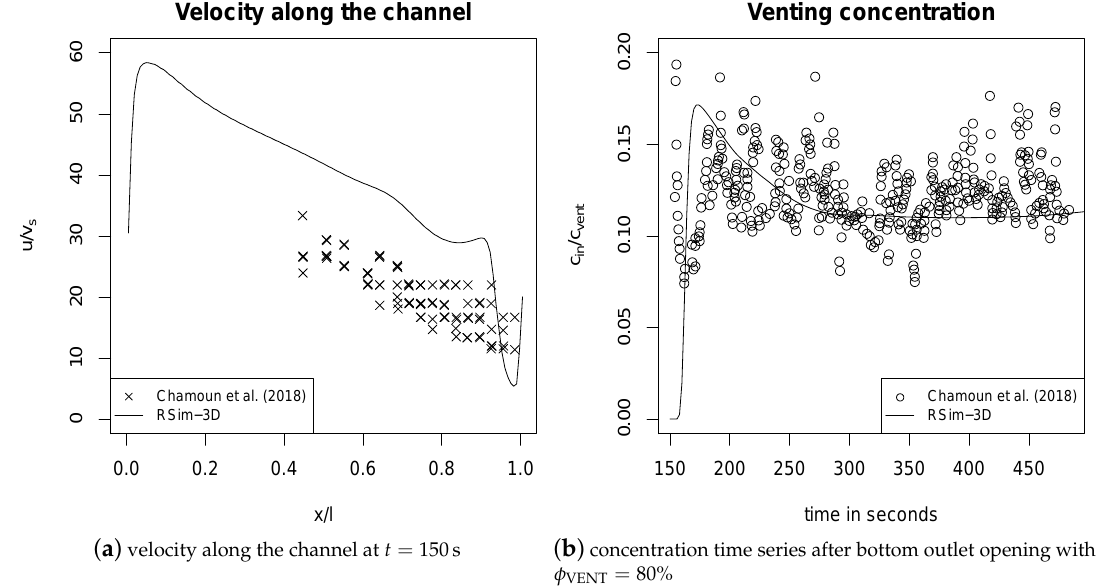
( b ) concentration time series after bottom outlet opening with φ Figure 6. Results of the venting experiments